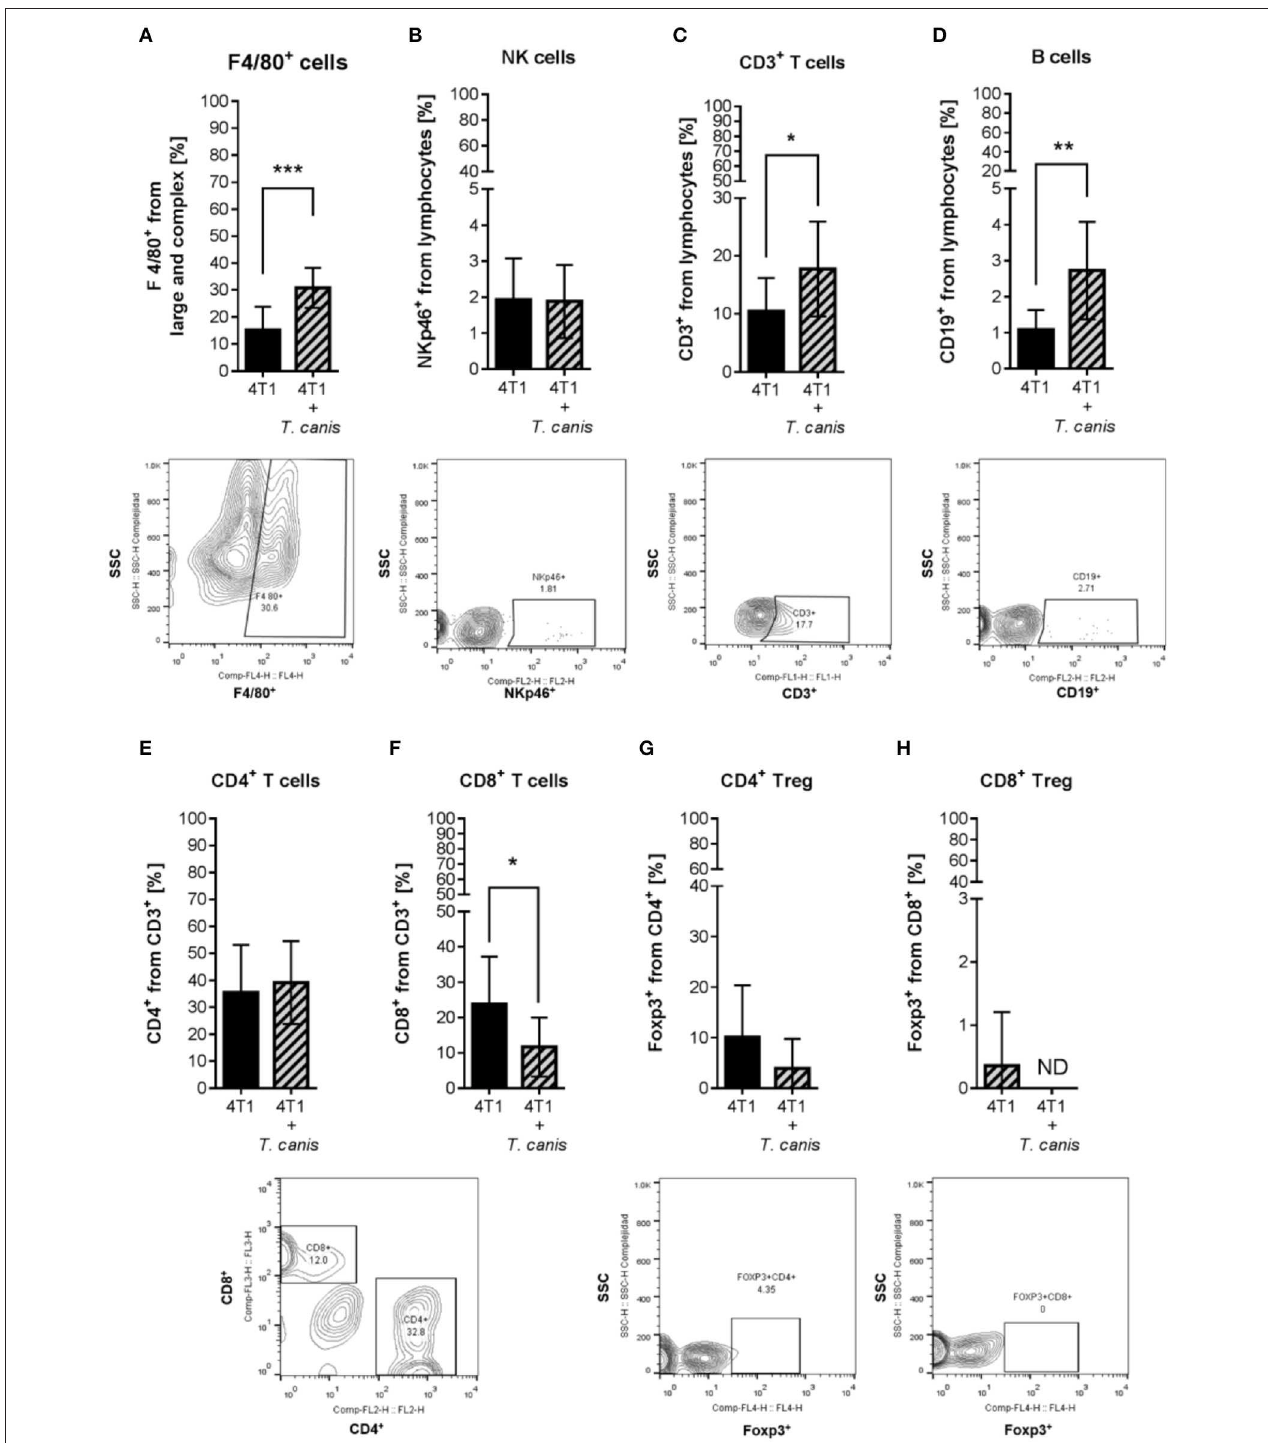
FIGURE 2 | Innate and adaptive immune cells in the tumor microenvironment. Determination of innate immune subpopulations by flow cytometry. (A) F4/80 + macrophages. (B) NKp46 + cells. Flow cytometry analysis of adaptive immune cells within the tumor. (C) T CD3 + . (D) CD19 + B lymphocytes. (E) CD4 + T helper lymphocytes. (F) CD8 + T cytotoxic lymphocytes. (G) CD4 + /Foxp3 + T lymphocytes. (H) CD8 + /Foxp3 + T lymphocytes. Graphs represent the mean ± SD of the data from two independent experiments (4T1, n = 10; 4T1 + T. canis , n = 10). Representative contour plots of the cytometric analysis of the corresponding population (below). Gate from 10,000 cells was collected. Statistical significance was calculated using a t -test (* p ≤ 0.05; ** p ≤ 0.01, *** p ≤ 0.001).